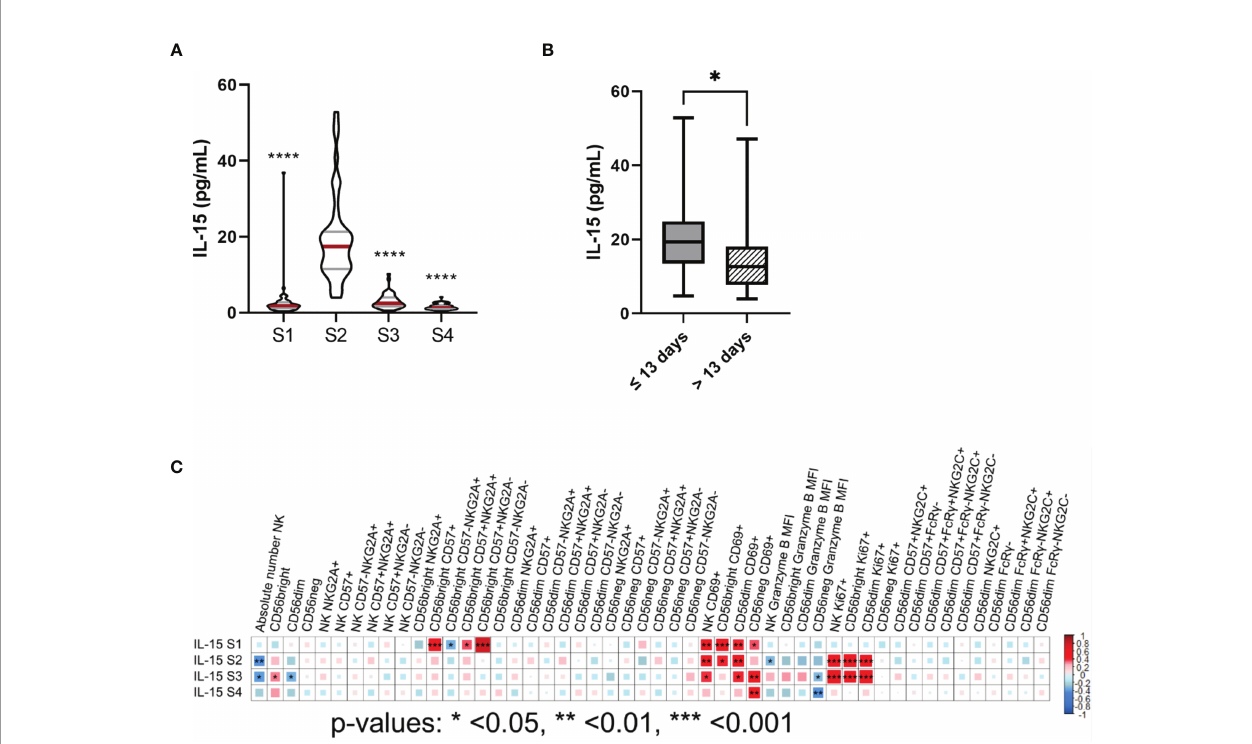
FIGURE 4 | IL-15 plasma levels are elevated at leukocyte recovery and associate with the number, proliferation capacity and the cytotoxic potential of NK cells after autoHSCT. (A) Violin plots showing the IL-15 plasma levels (pg/mL) at the four studied time points (S1-S4) (S1 n=54; S2 n=47; S3 n=45; S4 n=42). (B) Boxplot graphs showing the IL-15 plasma levels (pg/mL) of patients with a time period of ≤ 13 days (n=30) or >13 days (n=16) between autoHSCT and S2. (C) Correlogram showing Spearman correlation of the indicated fl ow cytometry data at S2 and IL-15 plasma levels. Violin plots show the median and the quartiles. Boxplots show the median and 25 – 75th percentiles, and the whiskers denote lowest and highest values. Signi fi cance of data in (A) was determined by comparing each sample with sample S2 using Wilcoxon matched-pairs signed rank test. Data in (B) was compared using Mann Whitney test.*p < 0.05, **p < 0.01, ***p < 0.001, ****p <